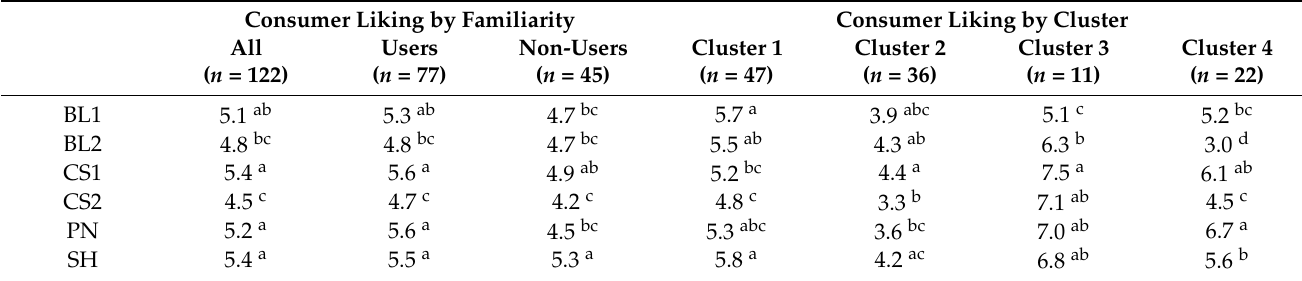
Table 6. Consumer’s acceptability of wine samples by all consumers, users, non-users and each clusters using total consumers’ liking data 1,2